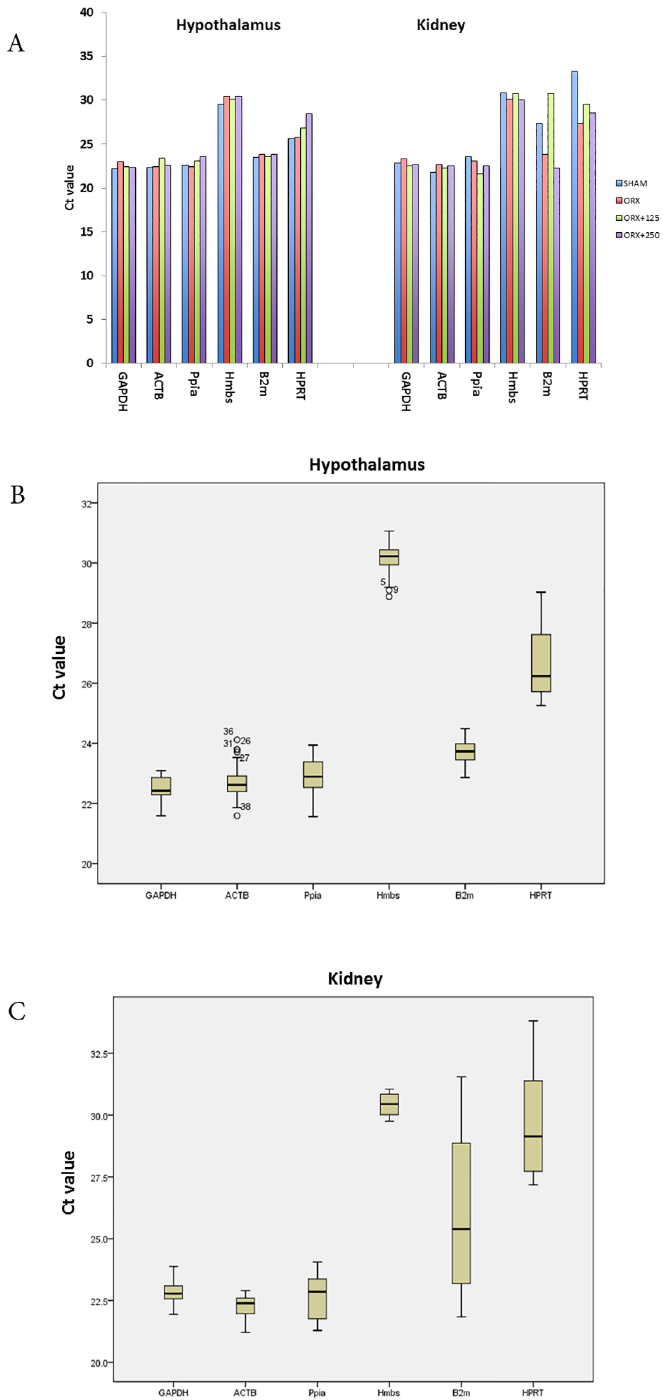
Fig 1. (A) Distributionof cycle thresholdof 6 different genes in hypothalamus (S1 Table) and kidney (S2 Table); 4 biological and 3 technicalreplicates were used. Mean Ct value of each gene in all treated groups were described.Lower level of Ct value implies higherexpressionlevel as for GAPDH, ACTB, Ppia in both tissue and B2m only in hypothalamus. (B, C) Box plot graphsof Ct values are shown as a square across the box is depictedas the median.The box indicates the 25th and 75th percentiles and the whiskerscaps representthe maximum and minimum values.